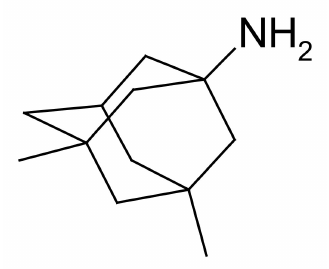
Figure 1. Chemical structure of